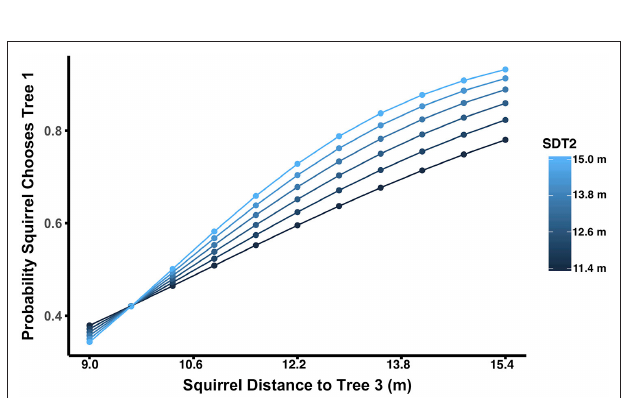
FIGURE 5 | As squirrel distance to Tree 3 increases, the probability of choosing Tree 1 increases. Lines depict the relationship between squirrel distance to Tree 3 and the probability of choosing Tree 1, with line color indicating the level of squirrel distance to Tree 2 (SDT2). When SDT2 is large, squirrel distance to Tree 3 tends to have a stronger effect on the likelihood the squirrel will choose Tree 1, although this was only marginally significant ( p = 0.066).